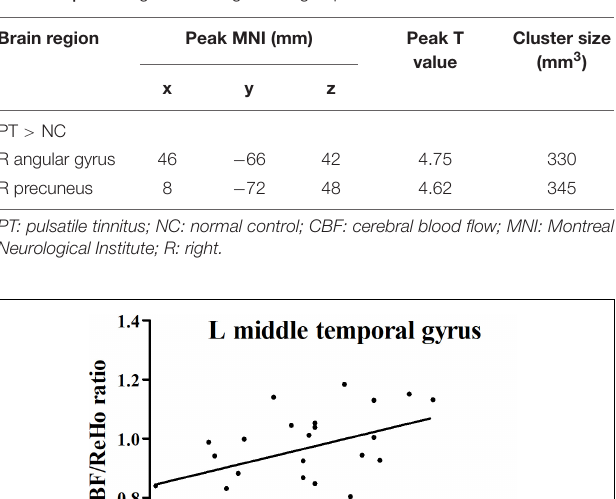
TABLE 3 | Brain regions with significant group differences in CBF.